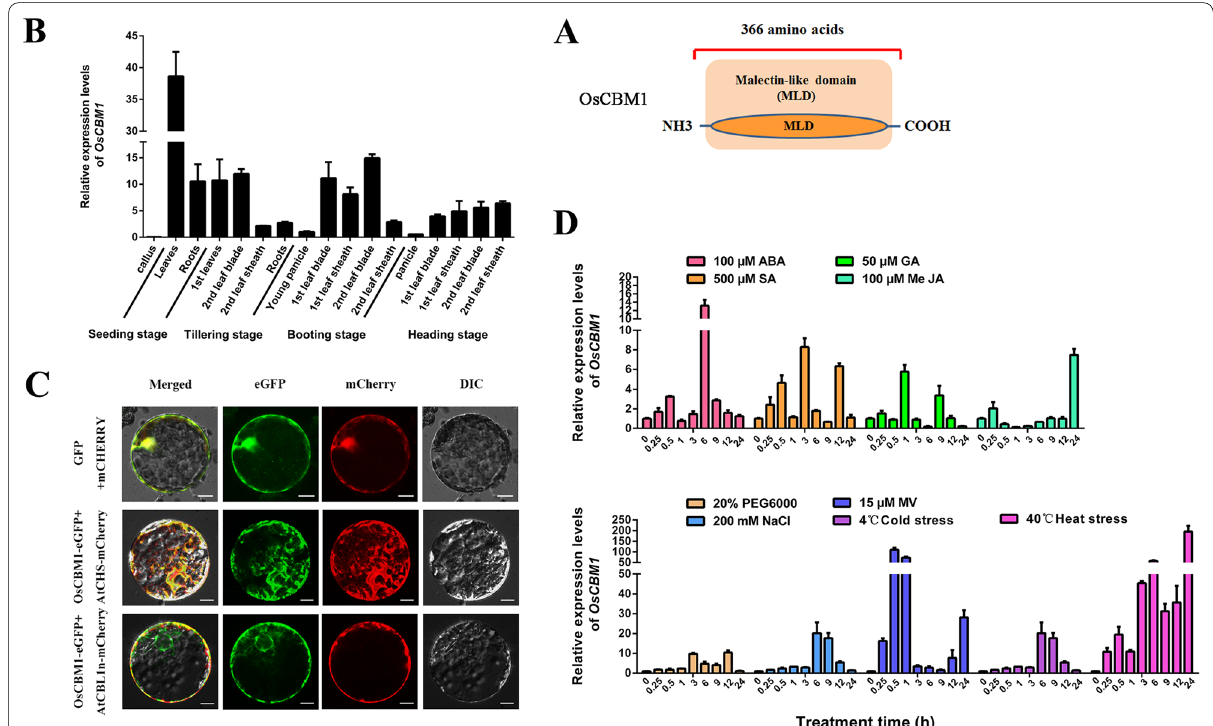
Fig. 1 Tissue‑specific expression patterns and subcellular localization of OsCBM1 in rice. A Protein structure of OsCBM1 , showing it is an only malectin‑like domain‑containing protein. B Tissue‑specific expression pattern of OsCBM1 . The wild‑type (WT, Nipponbare) of rice plants were allowed to grow in paddy fields and the different plant organs or tissues at various developmental stages, namely seedling, tillering, booting, and heading stages, were collected. After harvest, the developmental and tissue‑specific expression patterns of OsCBM1 were assessed with qRT‑PCR, using OsActin1 as the internal control. C Analysis of the subcellular localization of OsCBM1 using a Nicotiana benthamiana protoplast transient transformation system, showing both the endoplasmic reticulum (ER) and plasma membrane (PM) localization of OsCBM1. AtCBL1n‑mCherry served as a marker for PM protein localization and AtCHS‑mCherry was used as a marker for ER protein localization. Bars 10 μm. D Inducible expression = profiles of OsCBM1 in response to hormone treatments and abiotic stresses. Healthy and uniform rice seedlings (WT, Nipponbare) were selected and grown in a hydroponic solution. Two‑week‑old seedlings were exposed to various abiotic stresses and phytohormones, including ABA (100 μM), SA (500 μM), GA (50 μM), MeJA (100 μM), dehydration (20% PEG6000), salt (200 mM NaCl), oxidative (15 μM MV), cold (4 °C) and heat (40 °C). The whole leaf blades from the plants were harvested at 0, 0.25, 0.5, 1, 3, 6, 9, 12, and 24 h intervals after treatments. Relative expression levels of OsCBM1 were analyzed with qRT‑PCR using OsActin1 as the internal control. Data are means of three biological replicates (n =